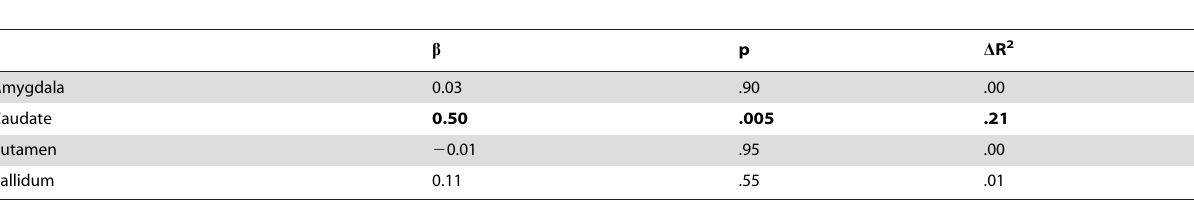
Table 3. Associations of birth weight with volume of subcortical gray matter regions of interest.